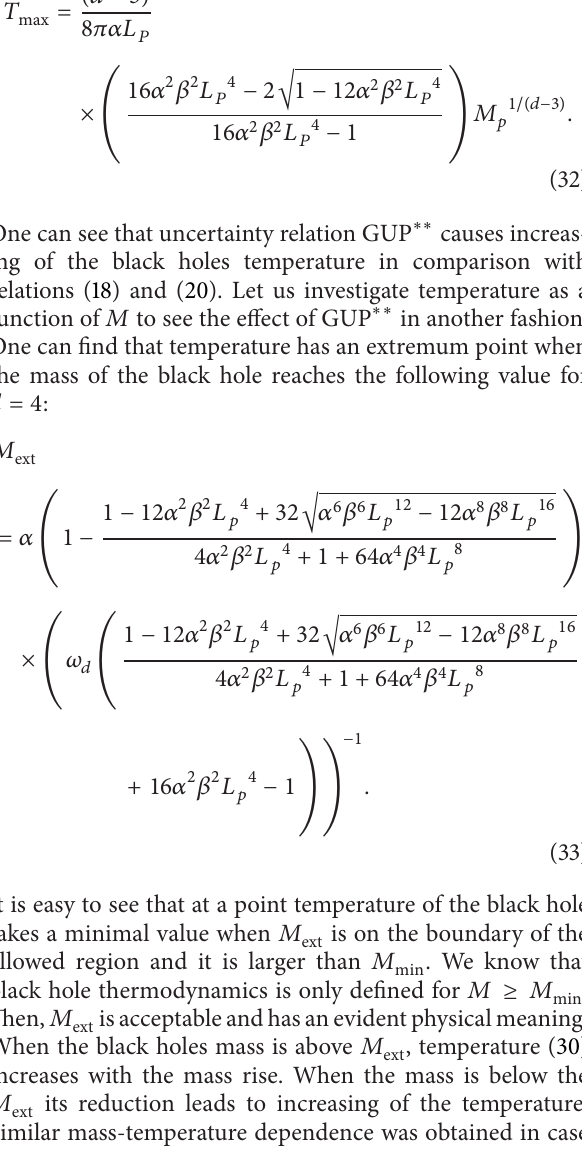
Figure 4: Black hole heat capacity as a function of mass for different numbers of space-time dimensions with 𝛼 = 1 in the presence of GUP ∗